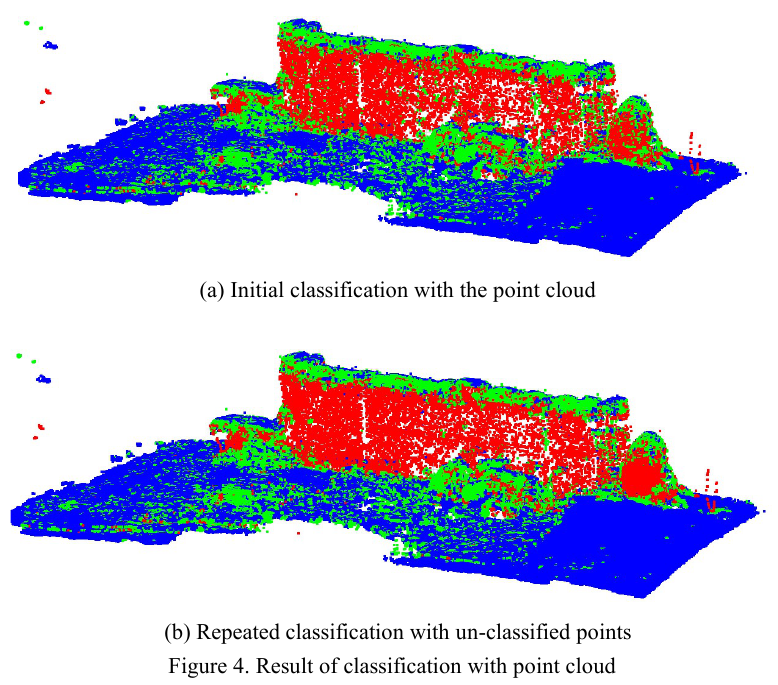
Figure 4. Result of classification with point cloud